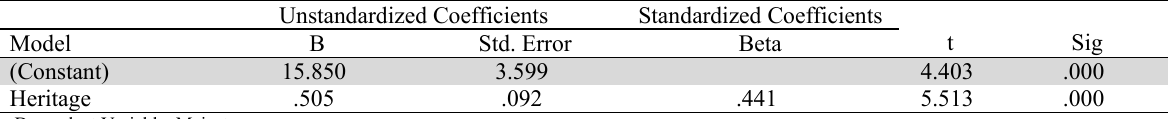
The summary of the regression analysis